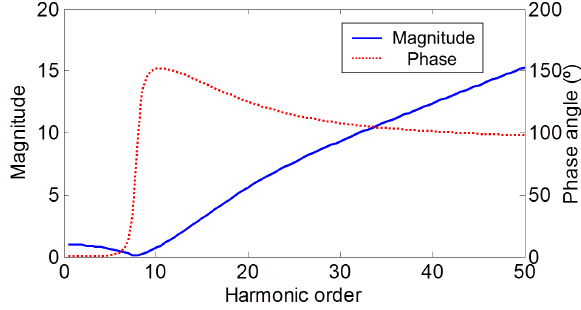
Figure 5. Magnitude and phase of the restoration factor of the equivalent WT model with respect to the harmonic order.